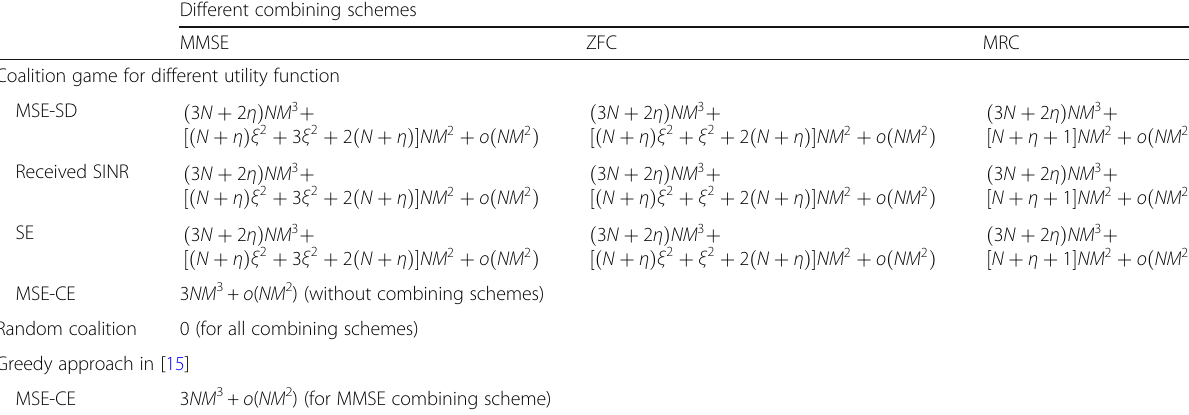
Table 2 The multiplication times during each search for different schemes Different combining schemes Coalition game for different utility